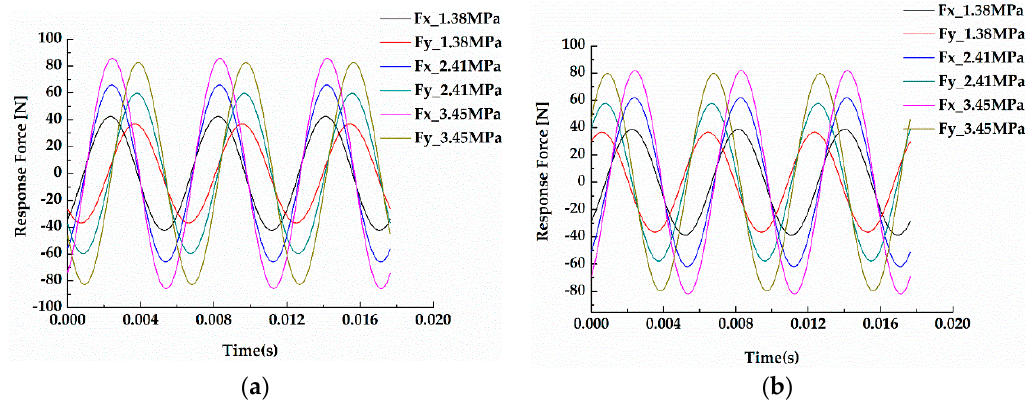
Figure 7. Reaction forces acting on the rotor as a function of time: ( a ) forward whirling, ( b ) backward whirling.